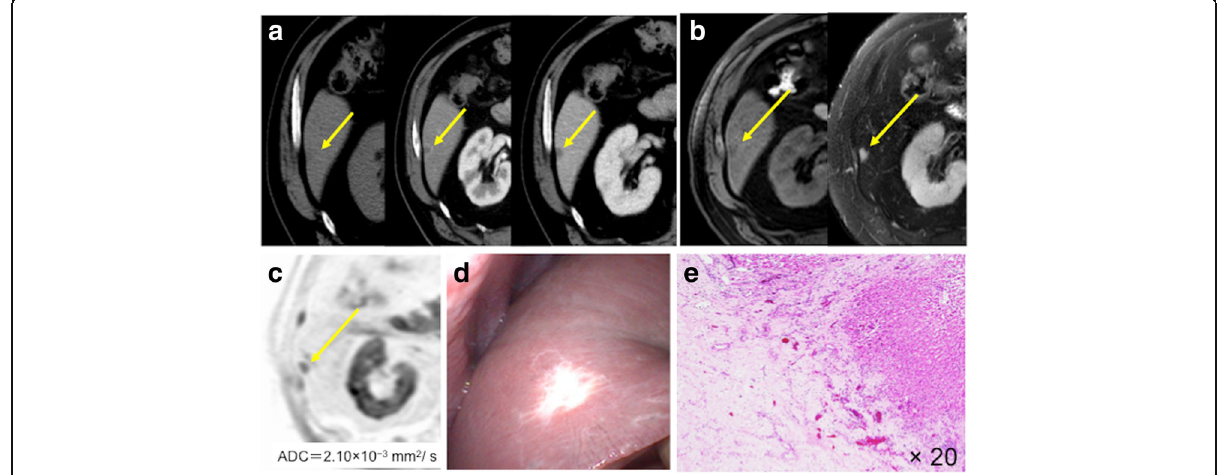
Fig. 1 The tumor showed ring enhancement in the arterial phase and low-density mass in the portal phase ( a ) in a CT image. MRI showed that HSH is a hypointense mass on a fat-suppressed T1-weighted image and a hyperintense mass on a T2-weighted MRI scan ( b ). The ADC mean value of the mass was 2.10 × 10 − 3 mm 2 /s on DW-MRI ( c ). A whitish tumor was shown on the liver surface and capsular retraction was identified ( d ). Histologically, there were many small vessels with fibrous replacement and hyalinization ( e